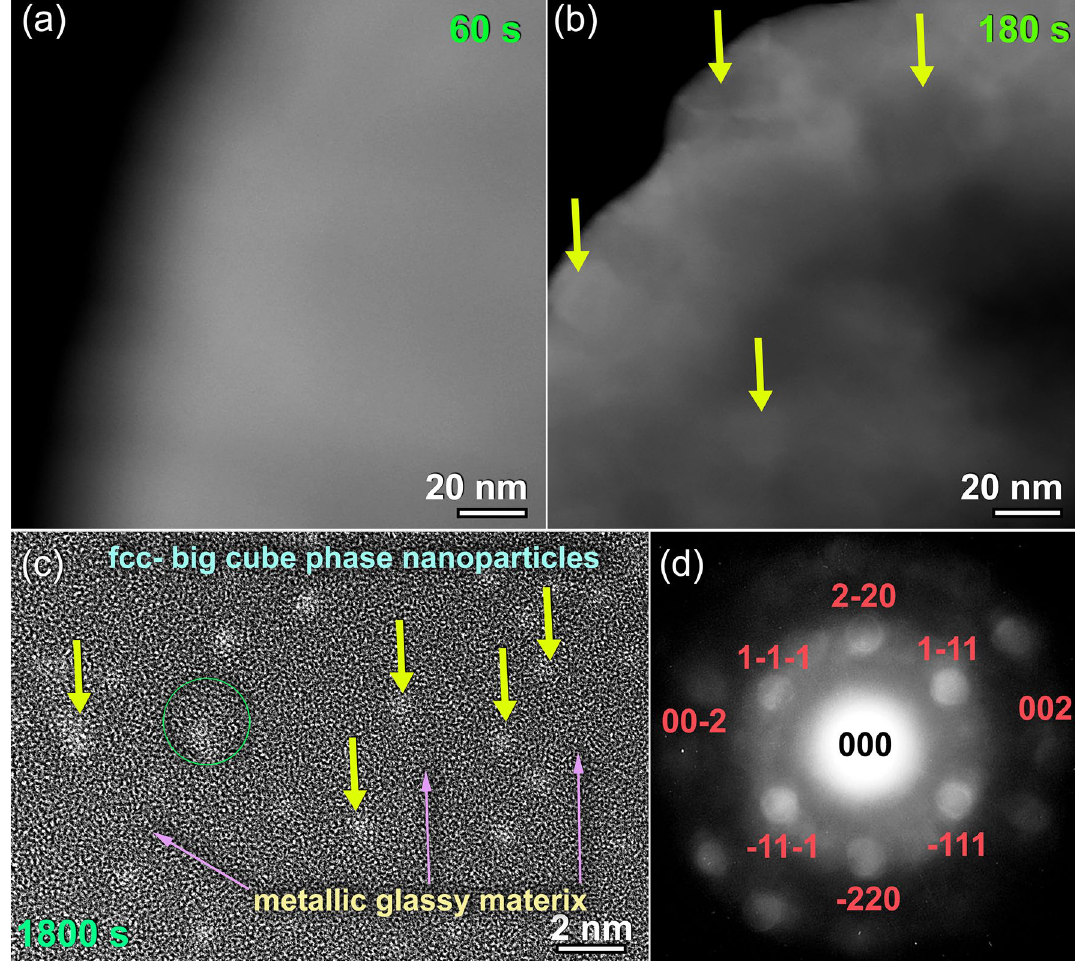
Figure 13. Scanning transmission electron microscope/dark field images (STEM/DFIs) of cold Cu 50 Zr 20 Ni 30 MG powders deposited on SUS 304 °C for ( a ) 60 s, and ( b ) 180 s. The atomic resolution TEM image, and the related NBDP of the circular symbol indexed in Fig. 12a for the powders deposited on the substrate for 1800s are displayed in ( c ) and ( d ),